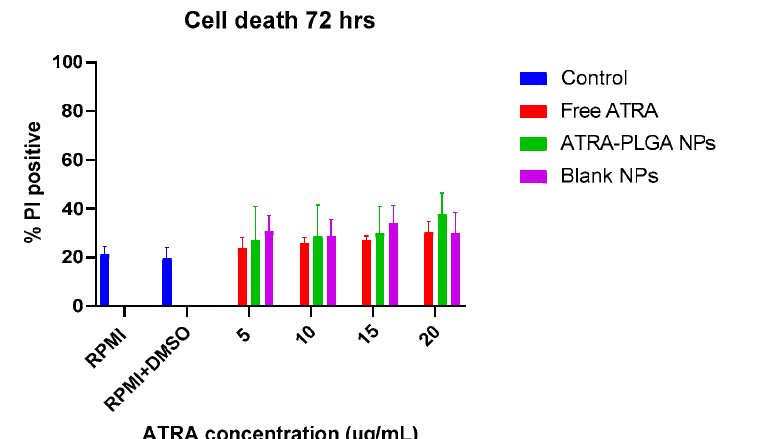
Figure 7. The effect of ATRA treatment on cell death. THP-1 cells were treated with free ATRA,